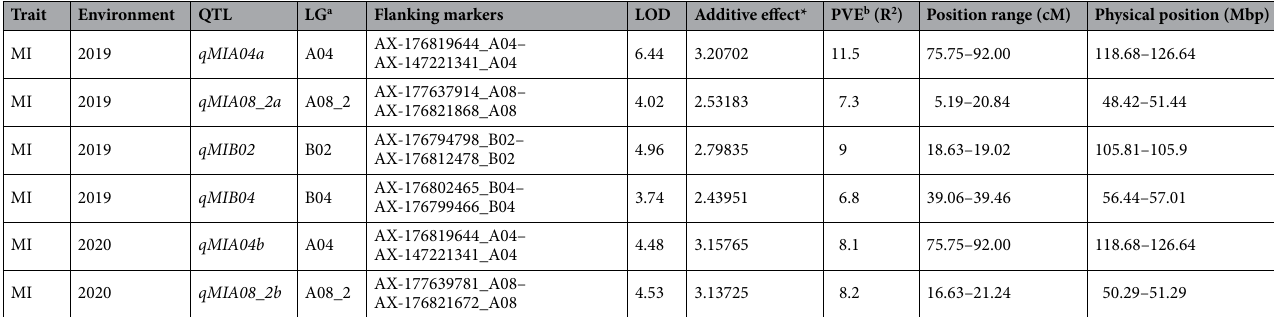
Table 4. QTLs identified for MI trait in the Harari × IGC119 RIL population. a LG linkage group, b PVE Phenotypic variance explained; *Additive effect for all the QTLs contributed by parent ’Harari’. MI, maturity